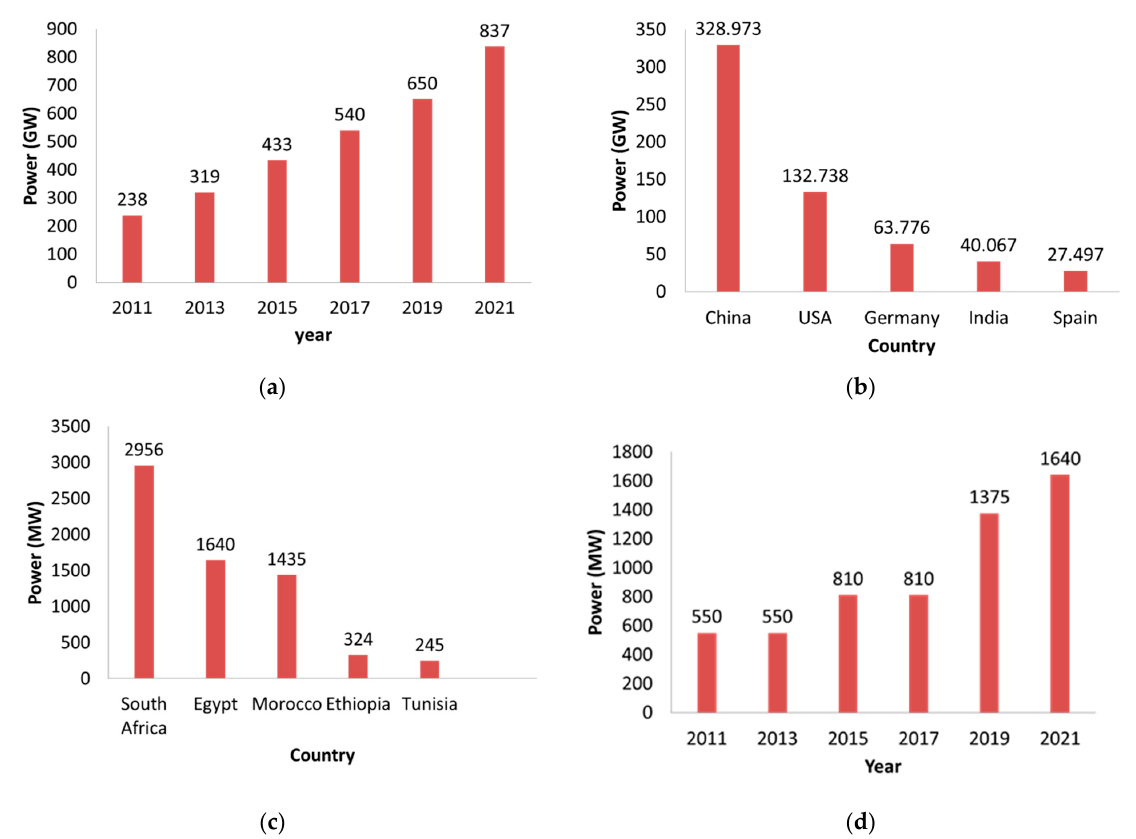
Figure 3. Wind energy trend in the world and in Africa and Egypt: ( a ) wind energy trend in the world; ( b ) top five wind power production in the world in 2021; ( c ) top five wind power production in Africa in 2021; ( d ) wind energy trend in